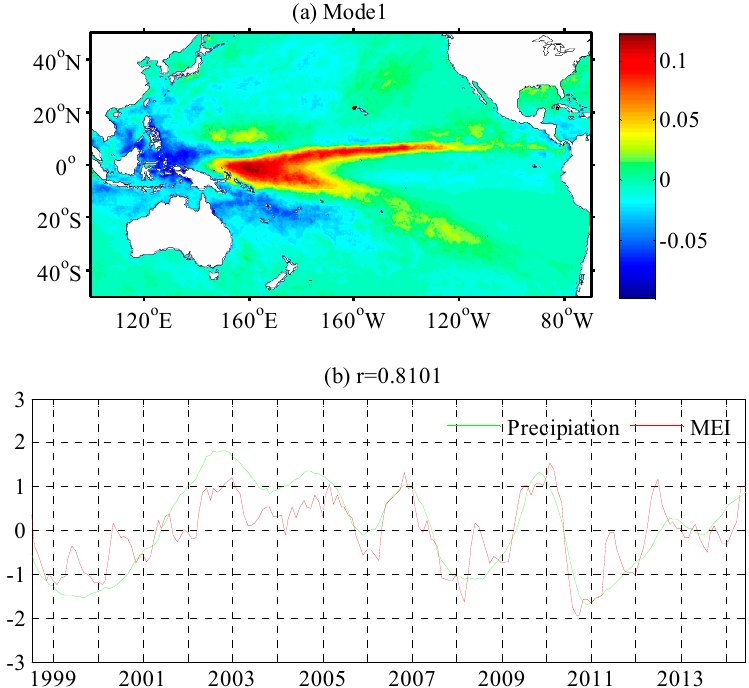
Figure 2. The EOF mode of interannual variability of precipitation in the Pacific Ocean. ( a ) Spatial distribution (Unit: mm/h); ( b ) green line represents the normalized principal component (PC) of the first EOF mode; red line represents the Multivariate ENSO index (MEI).